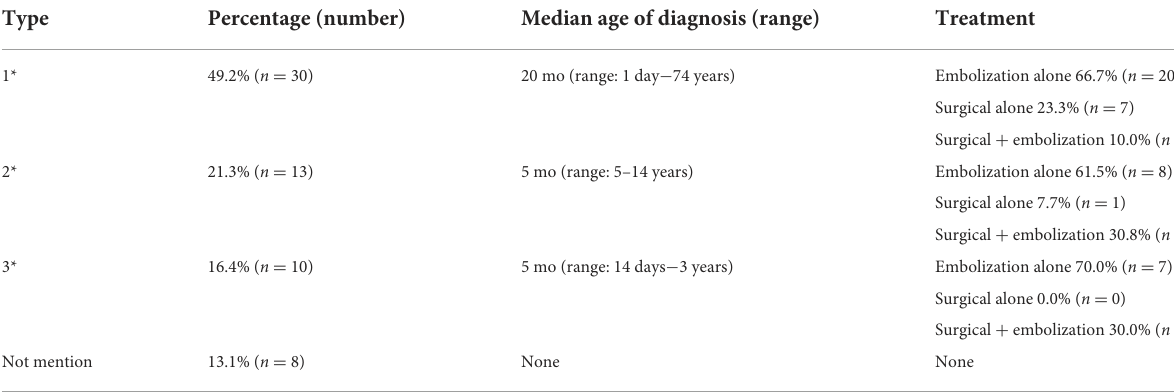
TABLE 2 Review of reported cases based on “Norton-Jacobson”